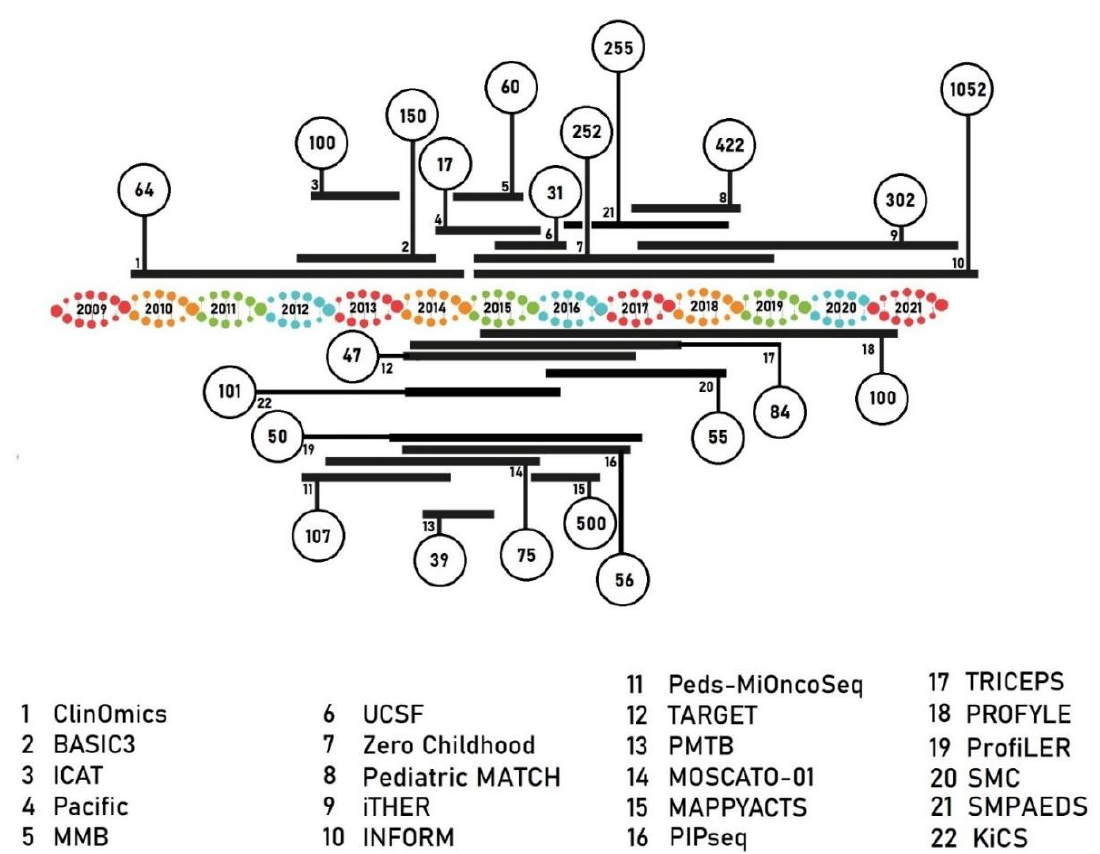
Figure 2. Precision medicine programs in pediatric oncology, showing the number of samples included. Horizontal bars indicating the timeframe in which patients were included.